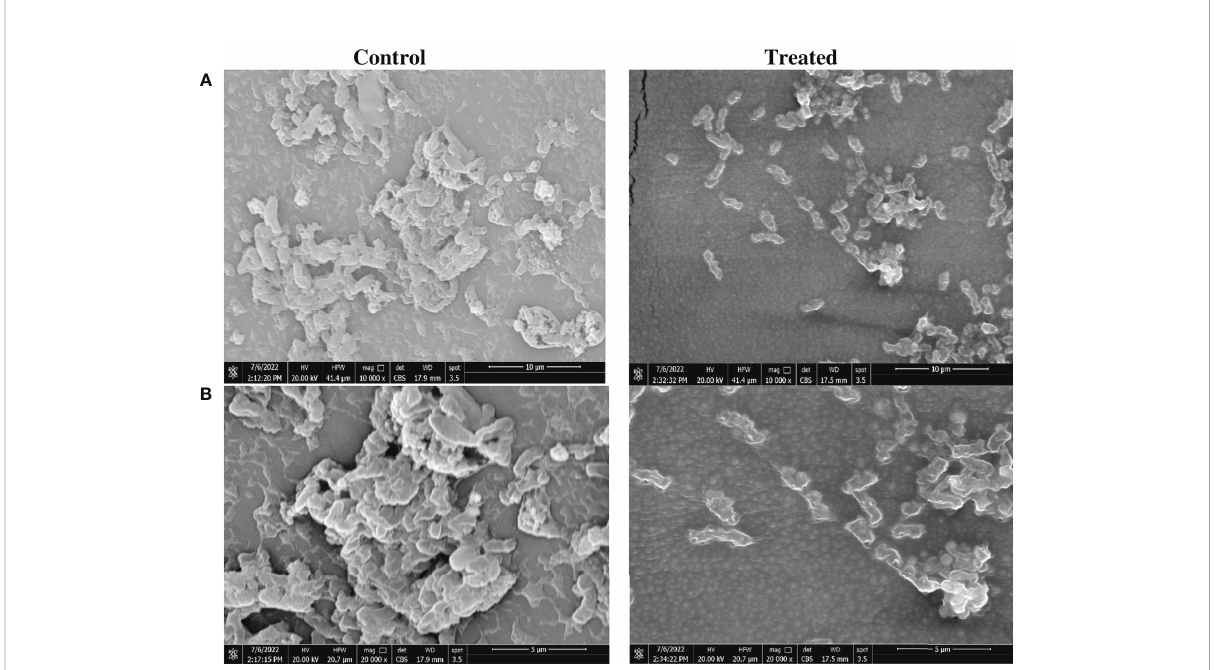
FIGURE 2 Morphological changes in Proteus mirabilis crystalline bio fi lm on indole impregnated silicone Foley catheter. Microscopic visualization of bio fi lm formation by P. mirabilis ATCC12453 on SFC segments using a scanning electron microscope (SEM). Bio fi lm formation on the catheter treated by impregnation at 0.5X MIC (0.6 mg/mL) of the indole extract (Zch127) was compared to control DMSO treated catheter. Visualization was done at magni fi cations of (A) 10,000 X and (B) 20,000